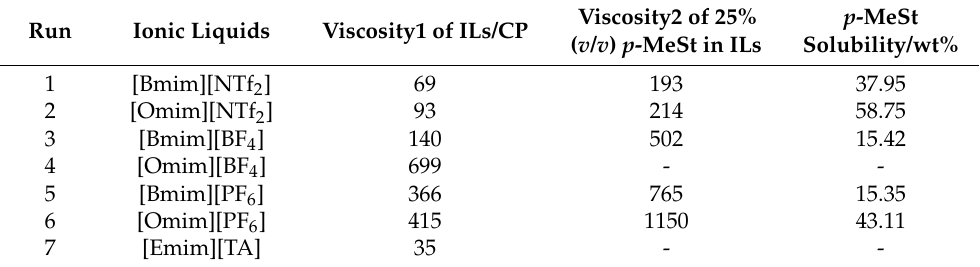
Table 1. Data of the viscosity1 of ILs, viscosity2 of 25% ( v / v ) p -MeSt in ILs, and monomer solubility a .